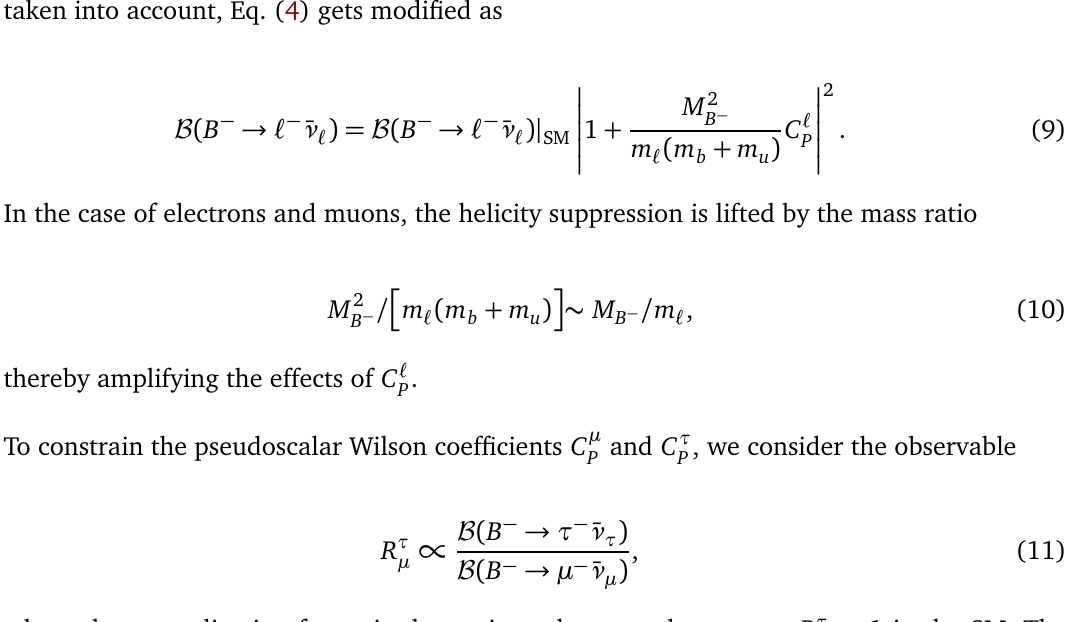
Figure 1: Allowed regions in the C